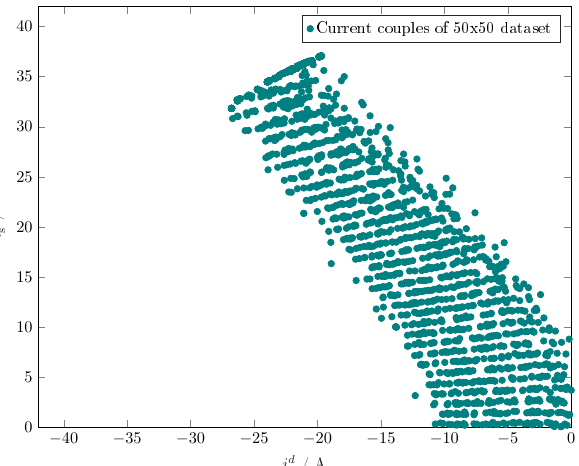
Figure 18. Distribution of the current couples of an exemplary dataset with constant current and voltage constraints ı s,max and u s,max but variable ω m and m m,ref (cid:98) (cid:98)